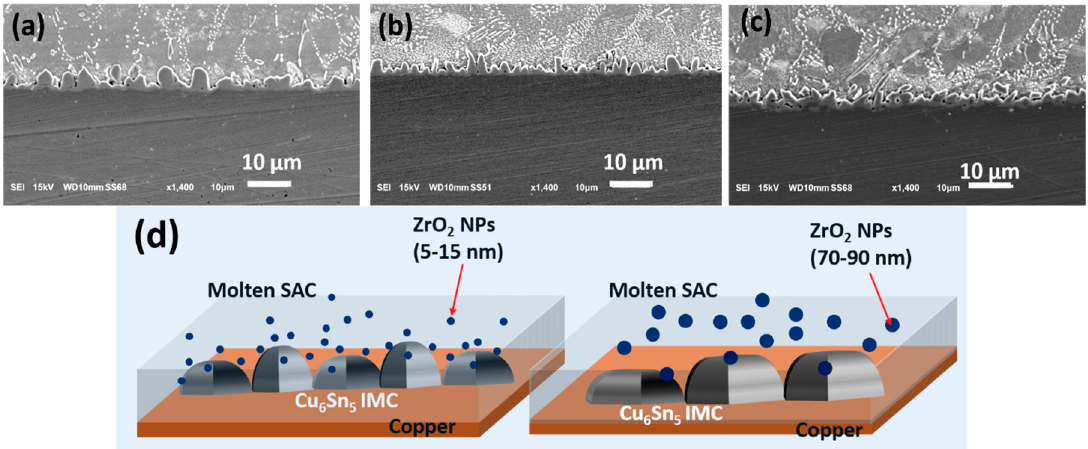
Figure 4. SEM micrograph showing Cu 6 Sn 5 IMC layer at the interface of as-reflowed ( a ) SAC 305/Cu joint, ( b ) SAC 305-ZrO2A/Cu joint, ( c ) SAC 305-ZrO2B/Cu joint and ( d ) Schematic illustration for the influence of smaller ZrO 2 A and larger ZrO 2 B NPs on the Cu 6 Sn 5 IMC growth .